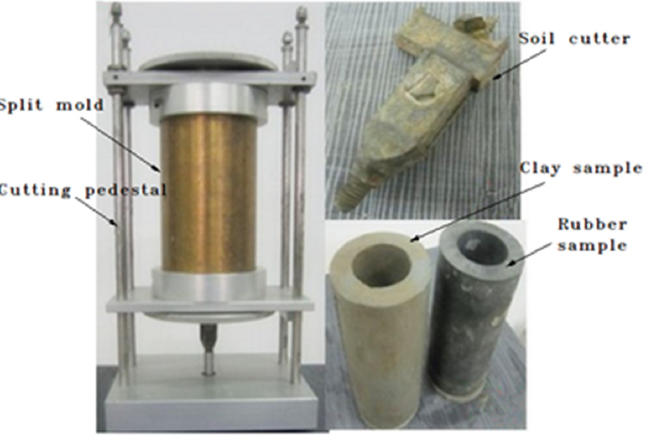
Figure 3. Method of making hollow cylindrical specimens.